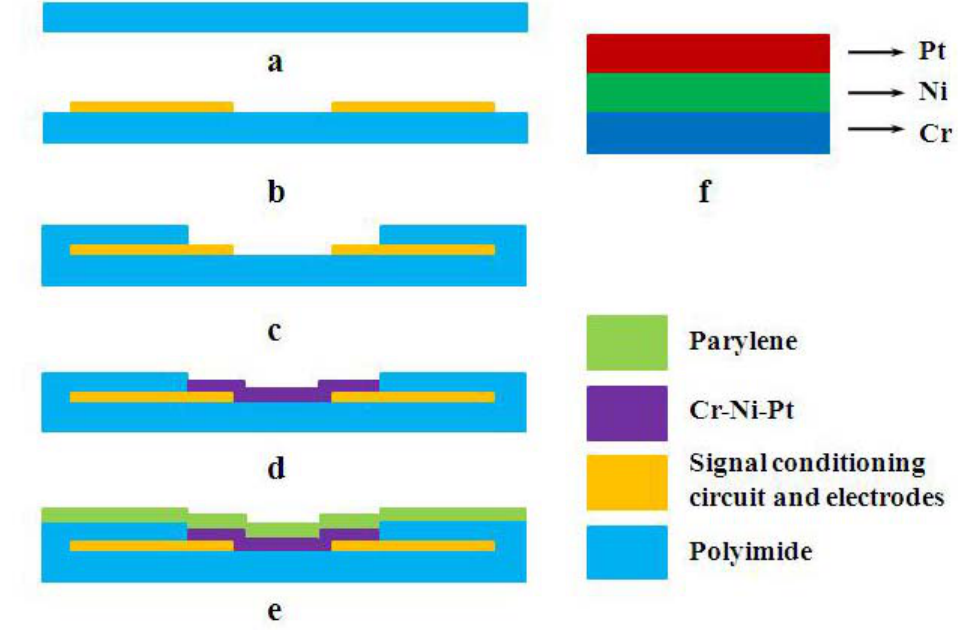
Figure 1. Fabrication process of hot-film sensor. (a–c) Standard printing technique on flexible printed circuit board. (d) Deposition of Cr-Ni-Pt thin-film. (e) Deposition of parylene. (f) The structure of the composite thin-film layer.